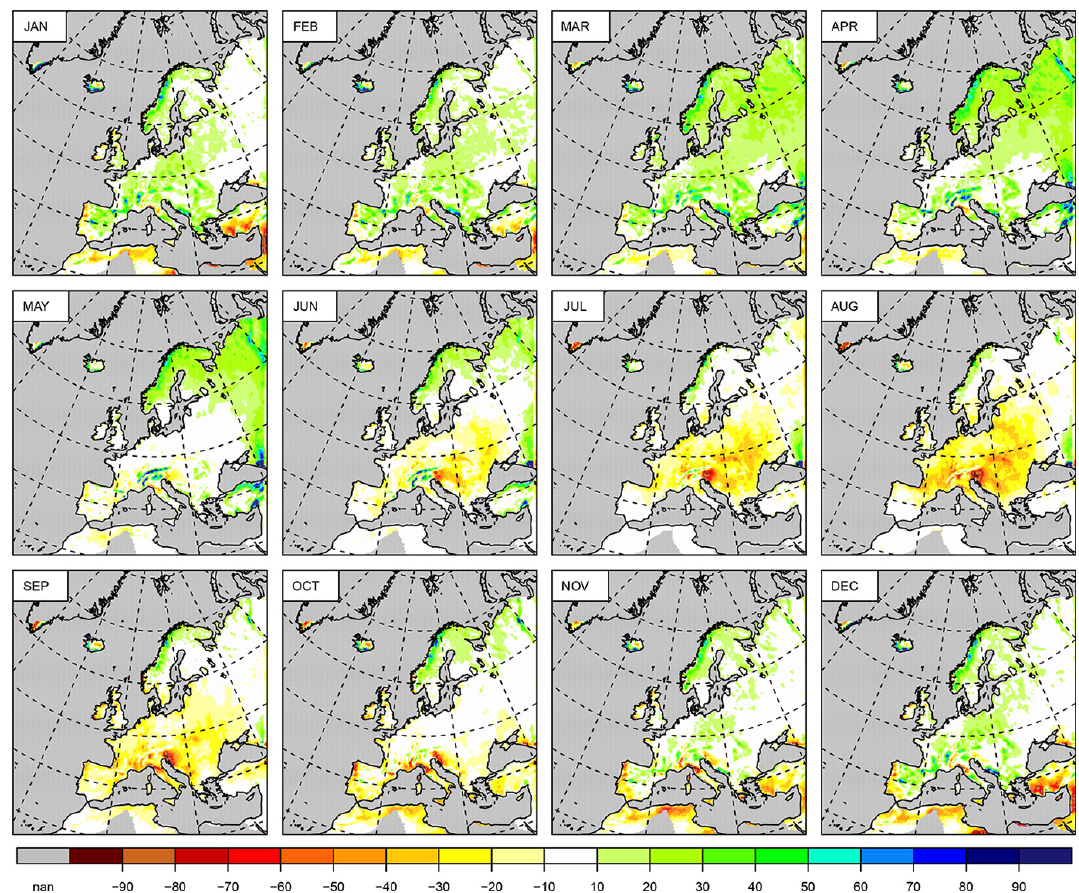
Figure 6. Di ff erences of mean monthly sums of total precipitation [mm] from 1950 to 2012: coastDat2-CCLM minus E-OBS8.0.